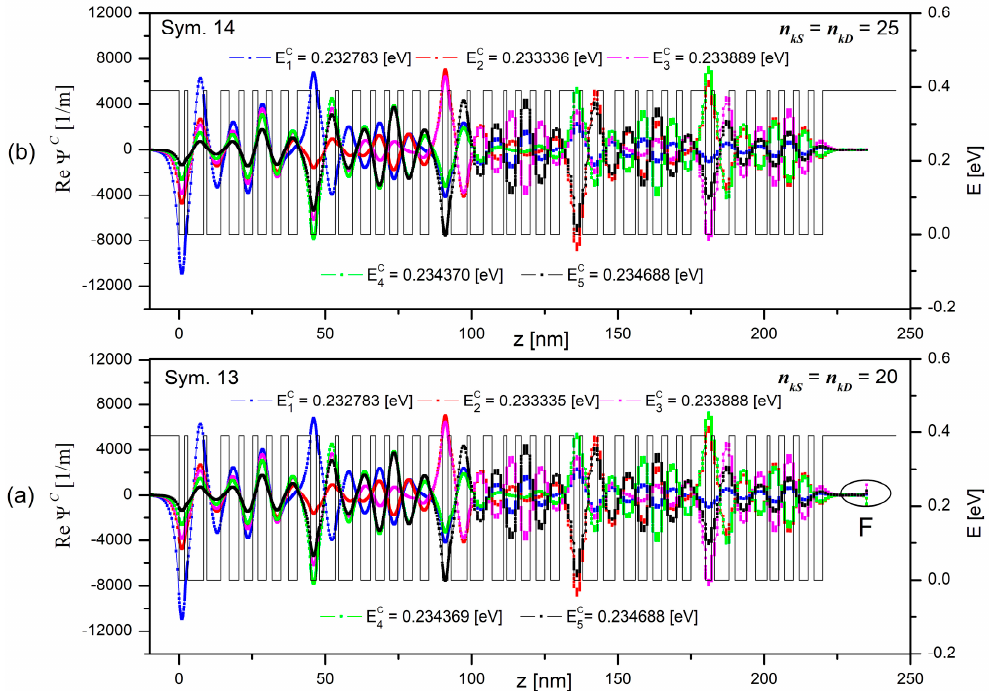
Figure 9. Convergence of the series (9) with the solutions to the Schrödinger equation (Re Ψ c ) depending on the degree of the approximating polynomial n k . The calculations were performed for the eighth miniband of the structure which consists of 5 QCL periods as described in [28]. Basic simulation parameters are listed in Table 6. Graph ( a ) shows the wave functions (Re Ψ c ) calculated for the parameters n kS = n kD = 20, graph ( b ) is the same wave functions calculated for the parameters n kS = n kD = 25.